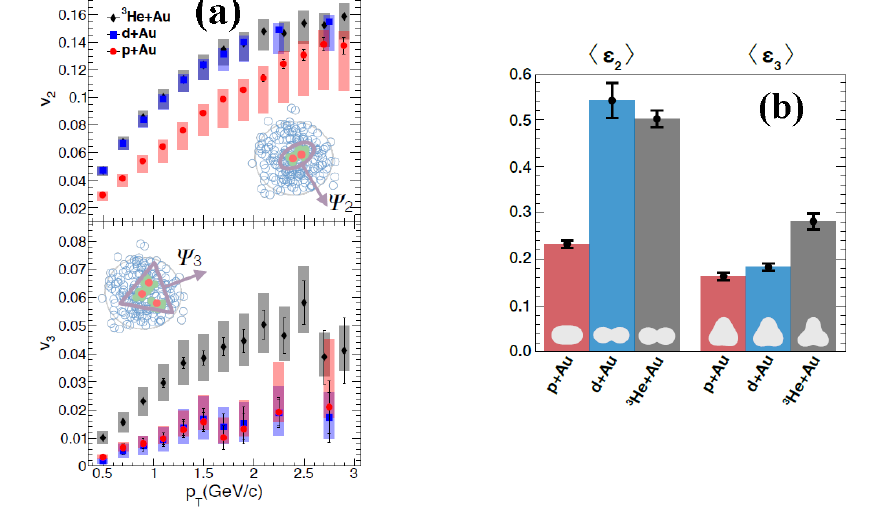
Figure 4. (a) Elliptic (v 2 ) and triangular (v 3 ) flow measured for charged hadrons in 0-5% most central p/d/ 3 He + Au collisions at  s NN = 200 GeV. (b) Mean values of the second and third order spatial eccentricities calculated using the Glauber Monte-Carlo model in 0-5% most central p/d/ 3 He + Au collisions at  s NN = 200